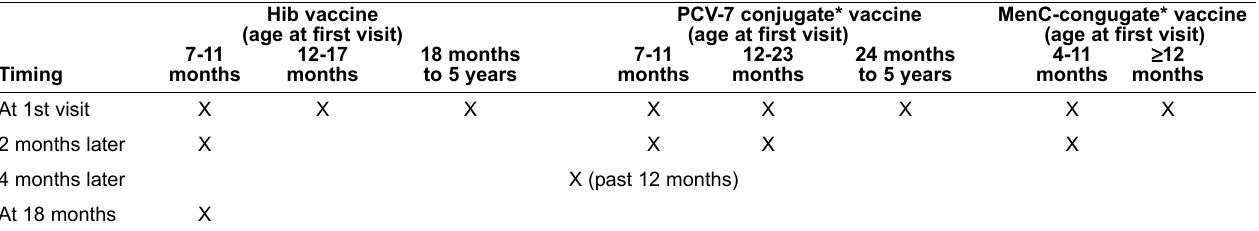
TABLE 4 Immunization schedule for vaccines against encapsulated bacteria for healthy children not previously immunized in the first three to six months of